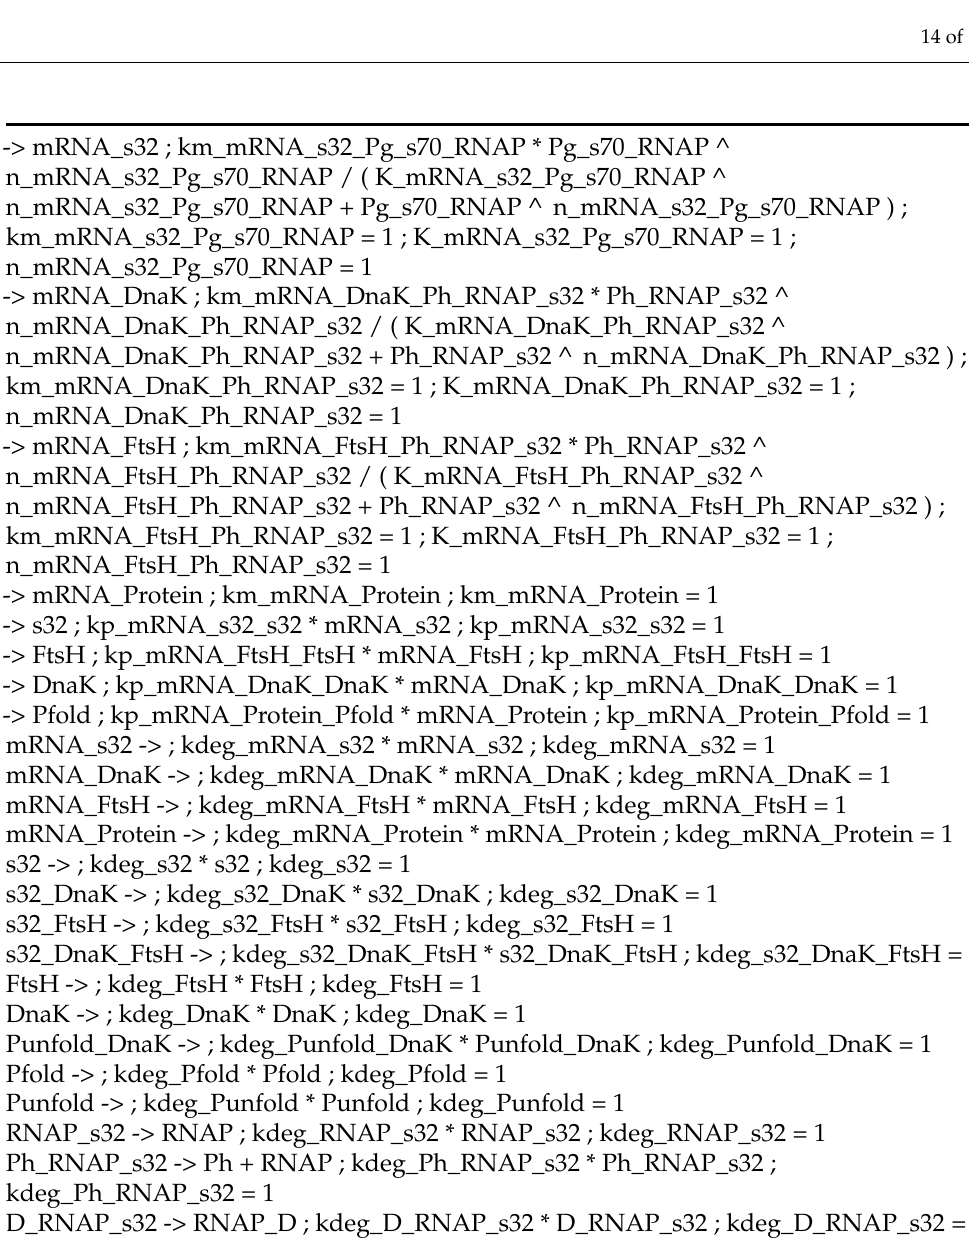
Scheme A5. The second half of the heat shock response model in Antimony language, created by KinModGPT with text-davinci-003